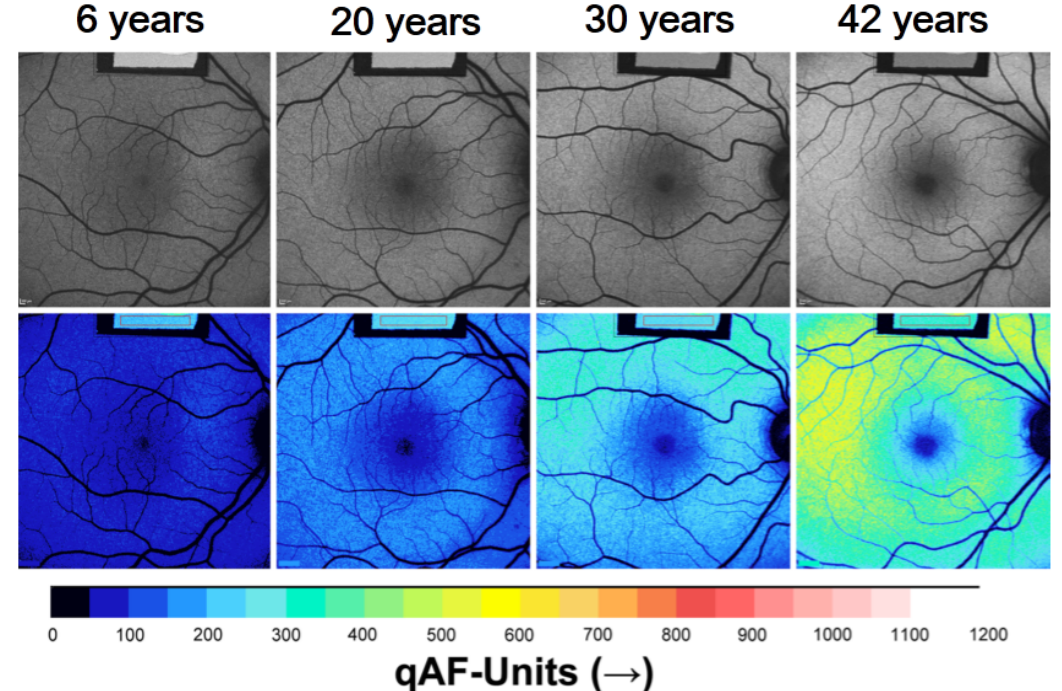
Figure 6. Quantitative fundus autofluorescence (qAF) in healthy human eyes. Short-wavelength fundus AF images (top row) and corresponding color-coded qAF images (bottom row) at the ages indicated. Lower qAF values are coded in blue and higher qAF values as orange (color scale). Fundus autofluorescence intensities increase with age and the highest levels occur in superior-temporal